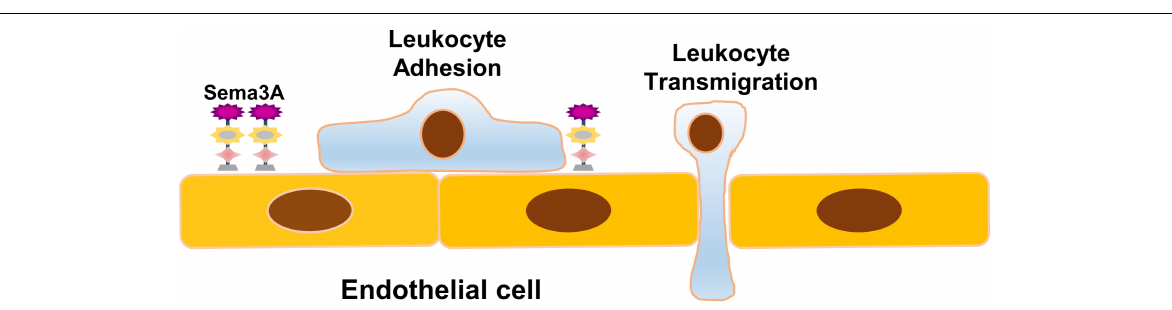
FIGURE 2 | Schematic representation of the role of Sema3A in atherosclerosis. Sema3A functions as a natural barrier to prevent monocyte migration into the arterial intima under basal conditions. Sema3A is abundantly expressed by endothelial cells in the atheroresistent greater curvature while little is expressed in the lesser aortic curvature. The downregulation of Sema3A in the d-flow-injured endothelial cells leads to inflammatory leukocyte trafficking into the intima, an initial essential step in the process of atherogenesis, and accelerates inflammation and atherosclerosis